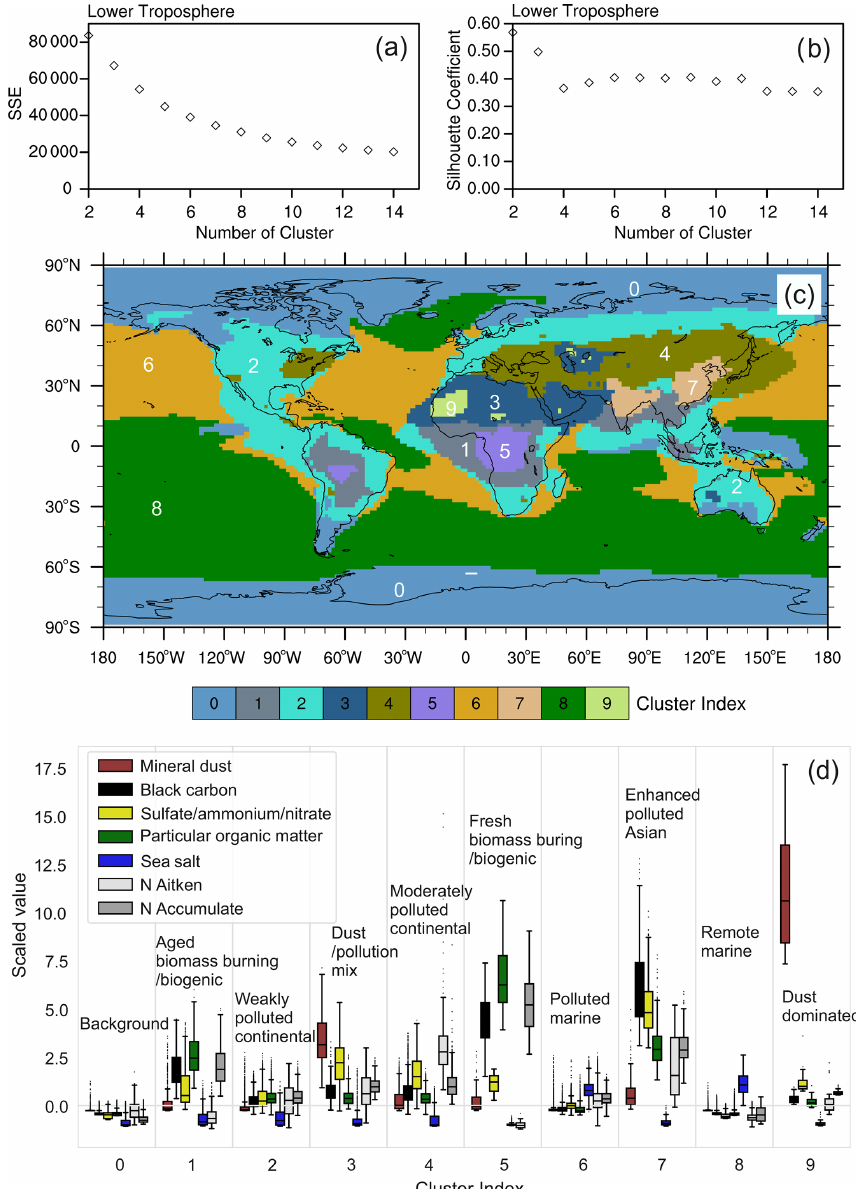
Figure 2. Lower-tropospheric clustering using K-means. The top row shows the evaluation metrics SSE (a) and SC (b) vs. a k range of 2–14. The middle row (c) highlights the spatial distribution of 10 aerosol regimes for the lower troposphere. The bottom row (d) shows the data distribution of the seven considered aerosol properties within the 10 individual aerosol regimes and cluster names assigned to each cluster based on the analysis of the aerosol data within the respective cluster. The boxplots describe the distribution of data by displaying five statistical quantities that are not outliers: the maximum value (top whisker), 75% quantile (top of box), median (middle line in box), 25% quantile (bottom of box), and minimum value (bottom whisker) of standardized aerosol parameters that are not outliers. The black dots are outliers, defined as the data beyond 2.67 σ of a normal